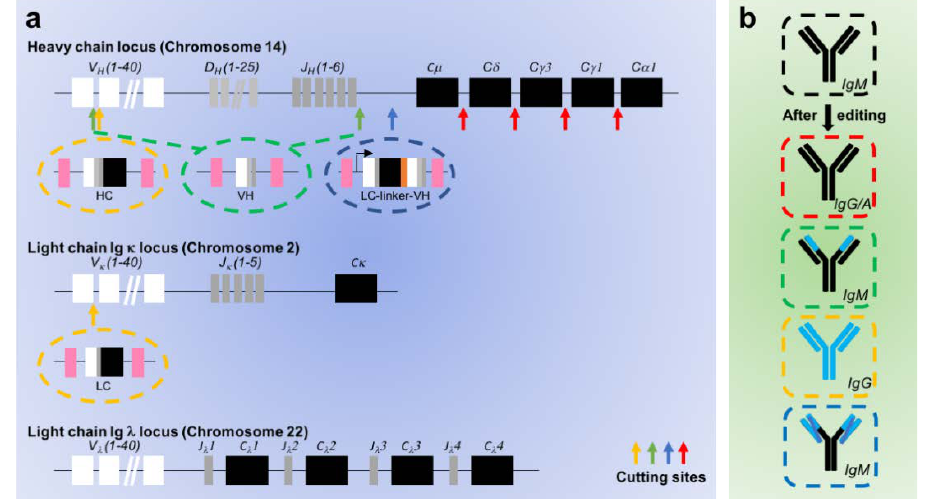
Figure 2. Reprogramming approach to edit of the endogenous BCR. ( a ) Cutting sites and DNA templates for BCR editing. The endogenous loci coding antibodies are displayed. The heavy chain is located on the chromosome 14 and comprises variable, joining, diversity and constant regions. The two types of light chains, κ and λ , are respectively located on chromosome 2 and 22 and comprises variable, joining and constant regions. The cutting sites targeted by different groups to edit genetically antibody loci are indicated by arrows (red [88], green [87], yellow [86], blue [85]). ( b ) Antibodies after editing. The resulting antibodies after gene editing are displayed bellow. The modified parts (different from the endogenous ones, in black) are indicated in blue.